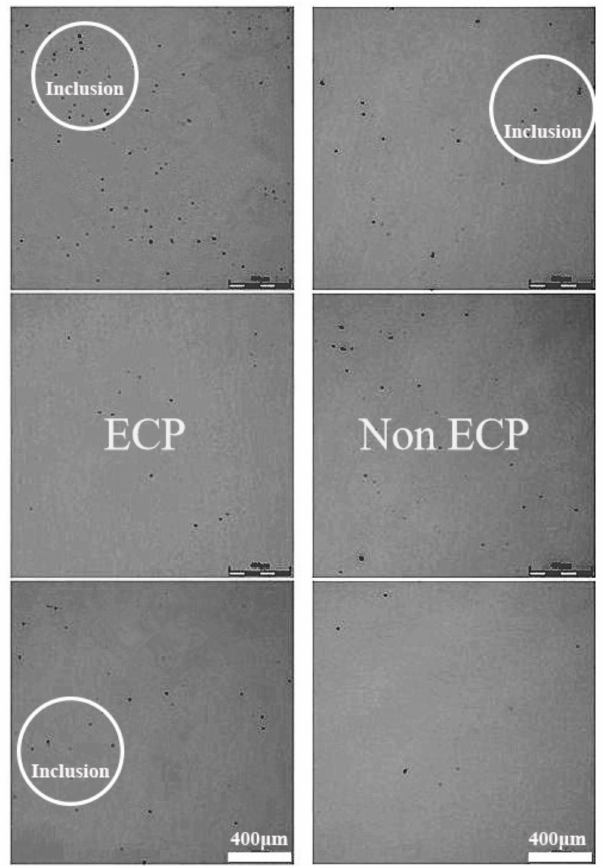
Figure 3. Micro morphology of inclusion distribution in the sample after electrified and non- electrified